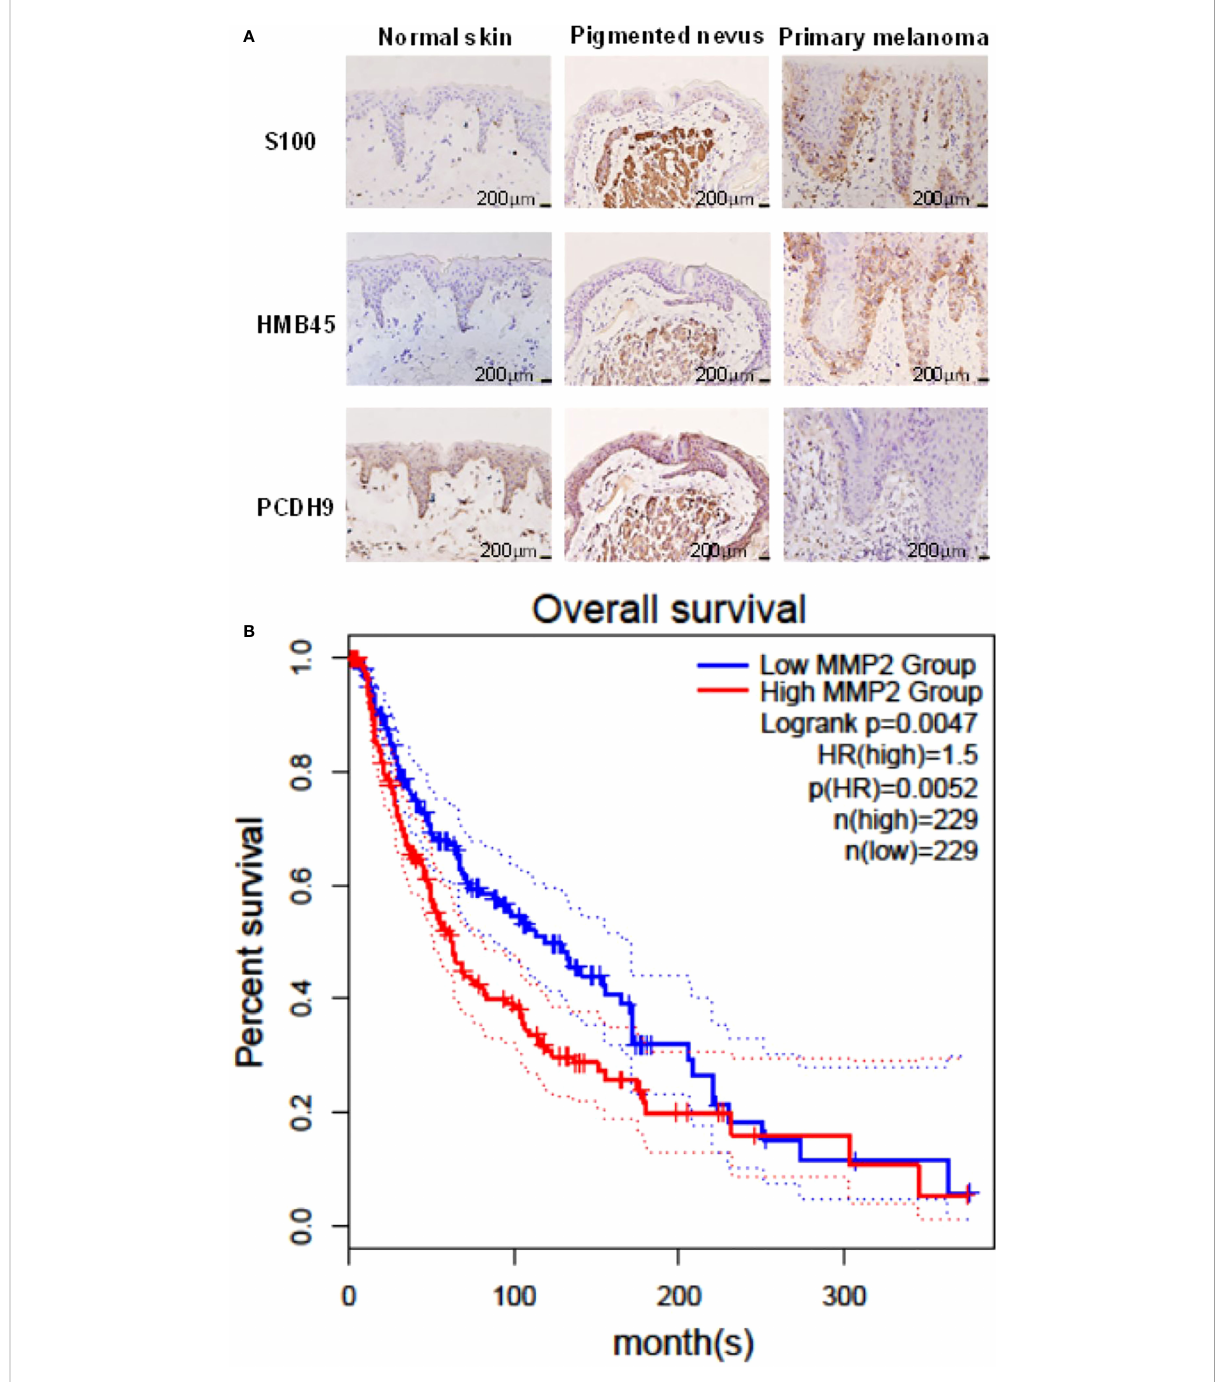
FIGURE 1 (A) Immunohistochemical analyses of PCDH9 expression in normal skin, pigmented nevus, and melanoma tissue. Positive percentage of PCDH9 expression was lower in human melanoma tissue than in normal skin or/and pigmented nevus tissue. PCDH9 was mainly expressed in cytoplasm but a small amount in nuclei. S100 and HMB45 are melanoma markers. The scale bar represents 200 m m. (B) Survival curves of MMP2 in normal and skin cutaneous melanoma (SKCM) tissues based on TCGA data in GEPIA. Red line represents the samples with MMP2 highly expressed (n = 229), whereas blue line exhibits lowly expression (n = 229) (log rank, p = 0.0047). HR represents hazard ratio. The p -value of HR is less 0.05 ( p =